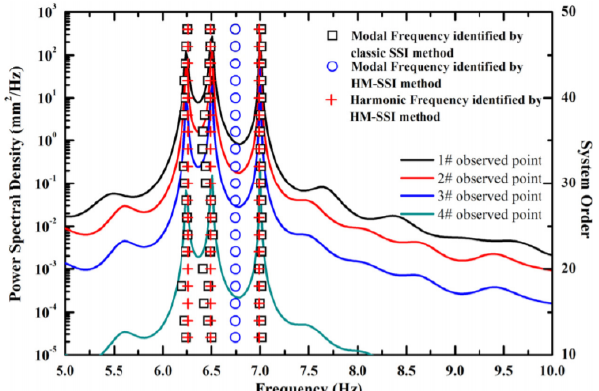
Figure 10. Stability diagram of system excited by white noise and three harmonic components. HM-SSI identified the harmonics as false modes, while SSI identifies them as structural modes. The true modal frequency is found by HM-SSI (Dong et al.,